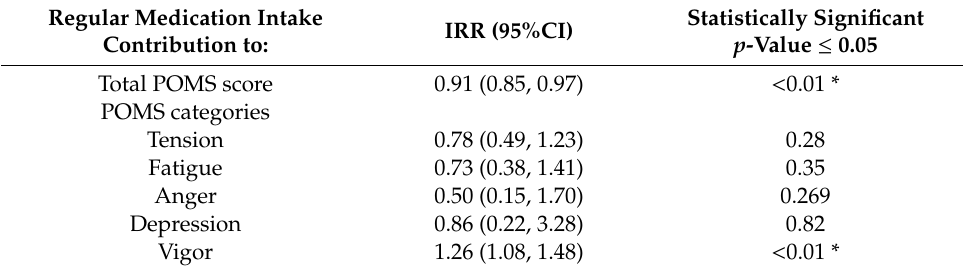
Table 5. Association between medication intake for total POMS and the different POMS categories scores a .